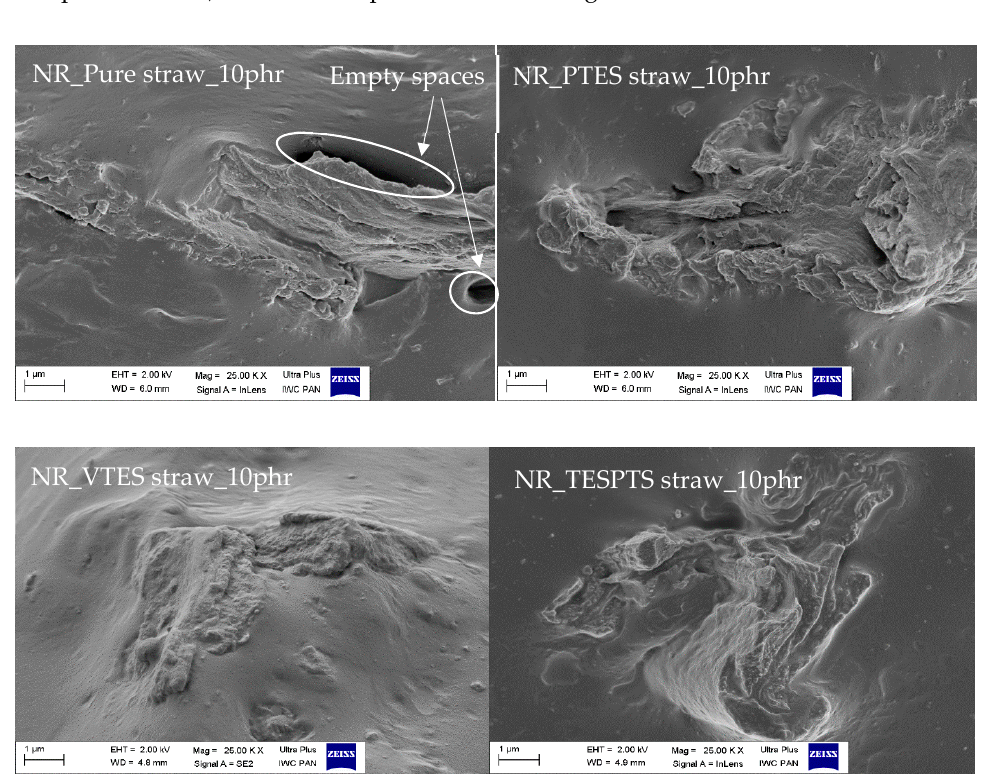
Figure 6. SEM images of composites with the addition of pure and modified straw (magnification ×25,000).